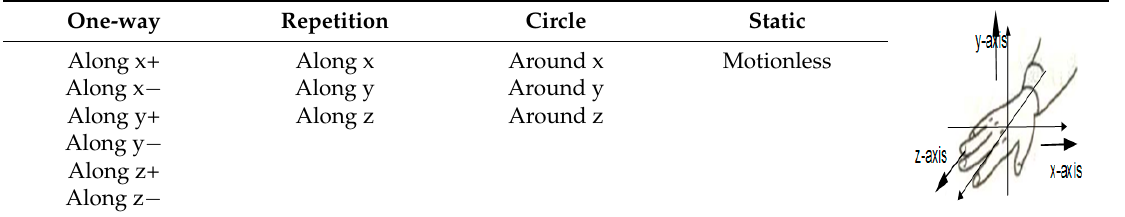
Figure 7. Three typical axis subclasses. Figure 8. Three typical rotation subclasses. 3.3. Gesture Recognition Results under Different Sizes of Training Sets As mentioned above, the extendibility of the proposed SLR framework is that the classification of a large-scale sign gesture set can be implemented based on training with small-scale set. In order to demonstrate the performance of the proposed method, we firstly conducted gesture recognition under different size of training sets using Sub3 and Sub5 as the reference subject, respectively. The determination method of the training set has been introduced in Section 2.6. The sign gestures, which contain typical component subclasses and were determined in the process of component subclass cluster analysis, were selected firstly to form the smallest training set of the component classifiers. For each component classifier, each typical subclass should appear only once in the smallest component training set, and the smallest gesture training set was the combination of five component training sets as depicted in formula Equation (10). The smallest training sets of subjects may be a little different from each other because they were determined separately. More